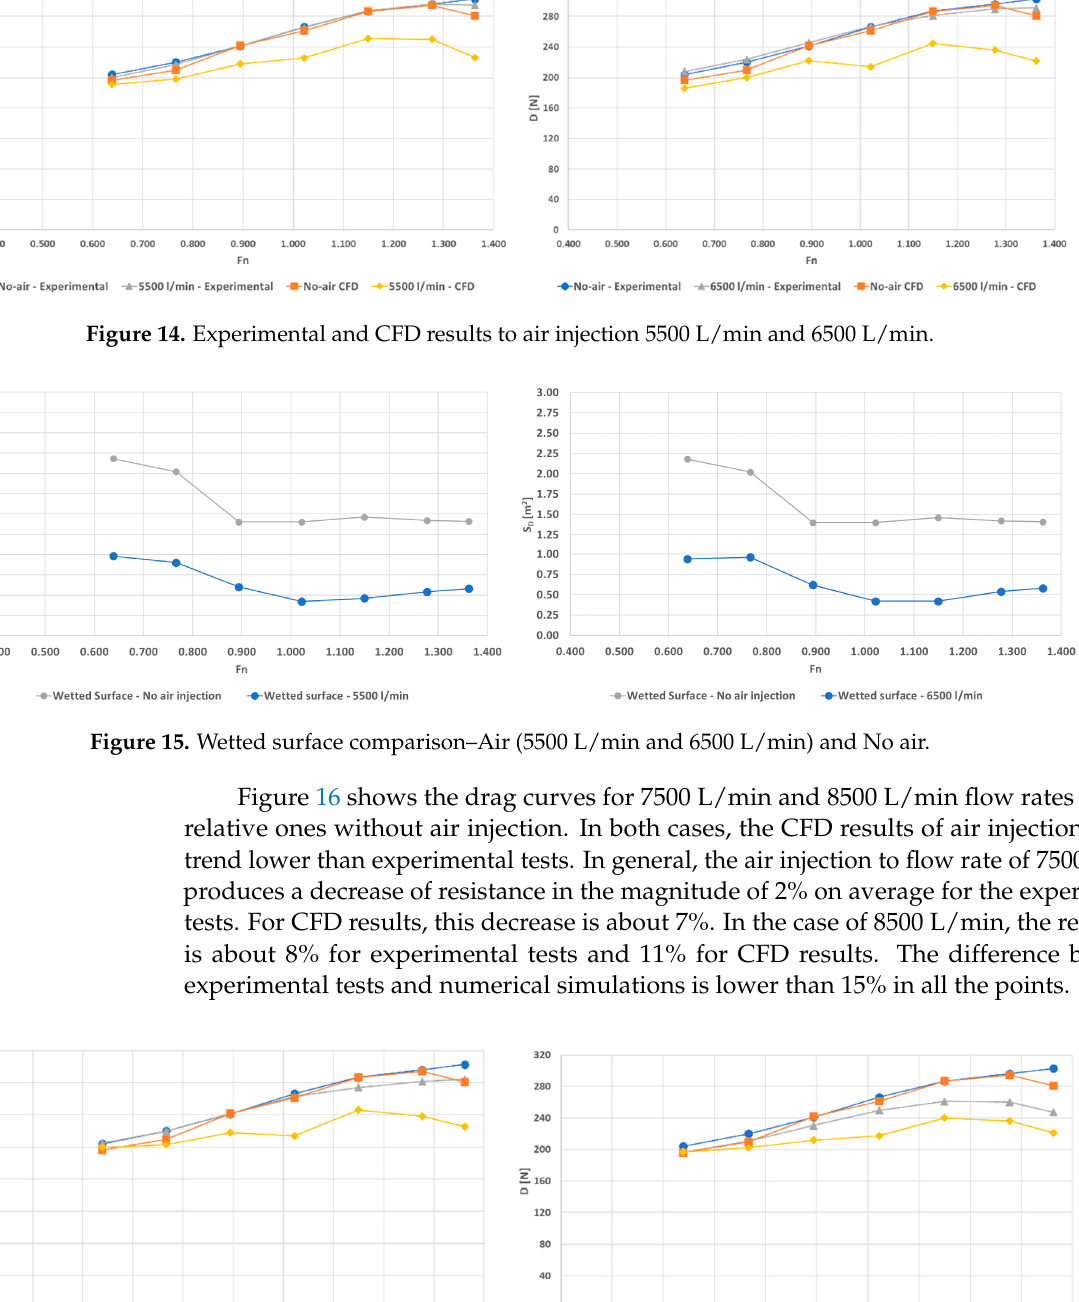
Figure 16. Experimental and CFD results to air injection 7500 L/minand 8500 L/min.